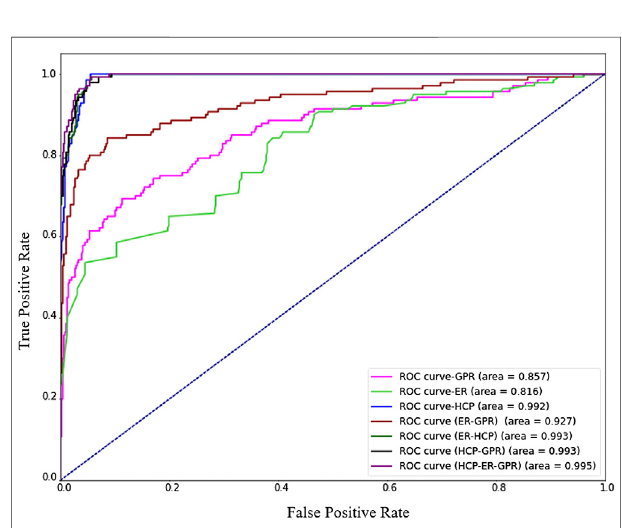
FIGURE 10 | Receiver Operating Characteristic curve of Support Vector Machine for corrosion